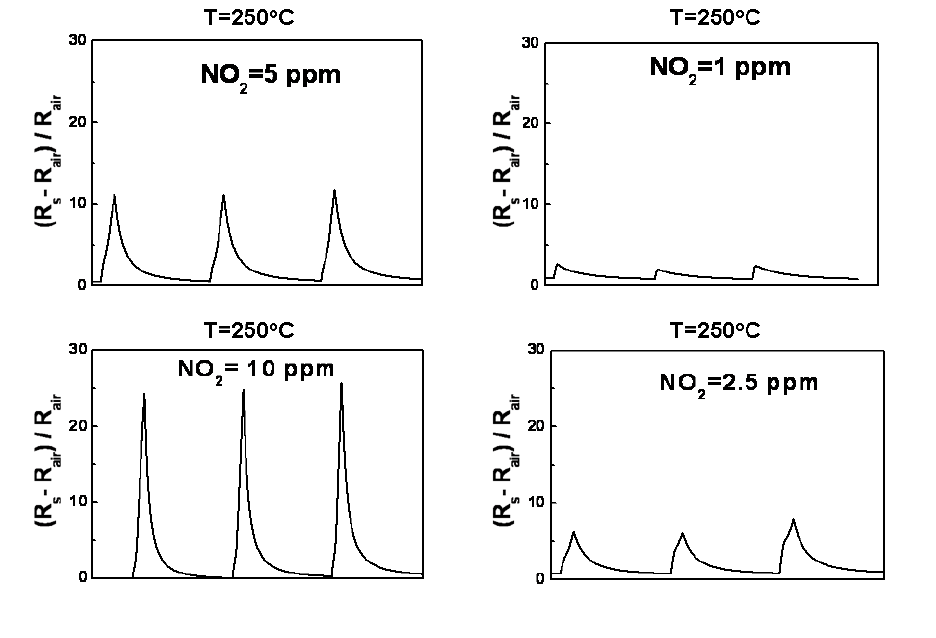
Figure 5. Repetitive response curves of ZnGa operated at 250 °C. The different concentrations of testing gas are 1 ppm, 2.5 ppm, 5 ppm, in N carrier gas. and 10 ppm NO 2 2